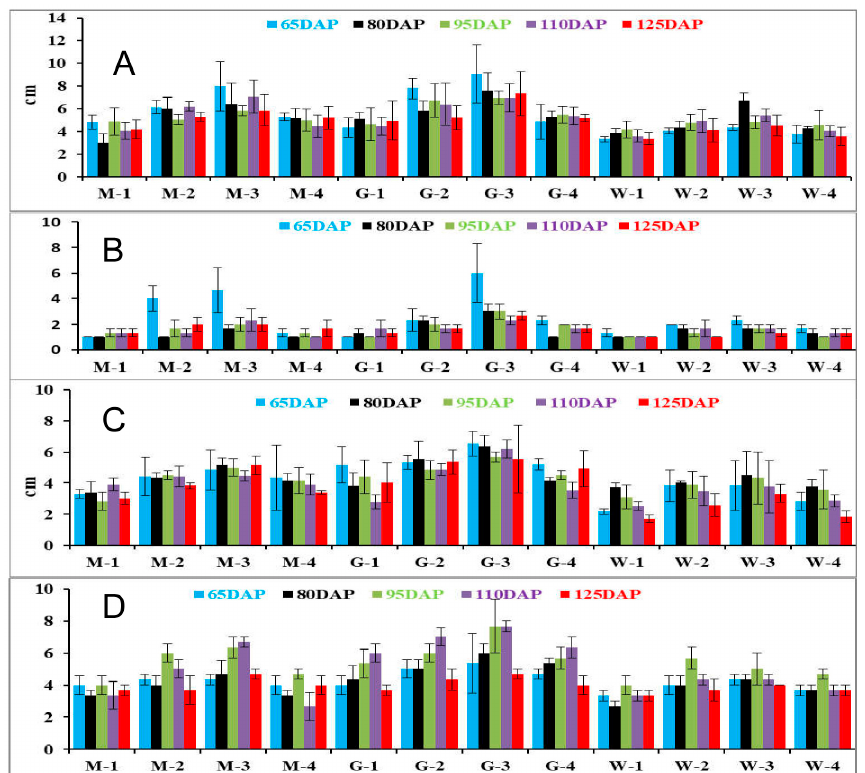
Figure 2. Root length ( A ), number of roots ( B ), shoot length ( C ) , and number of leaves ( D ) of the seedlings from immature embryos of the controlled crossing between RL and X grown in different combinations of the medium.